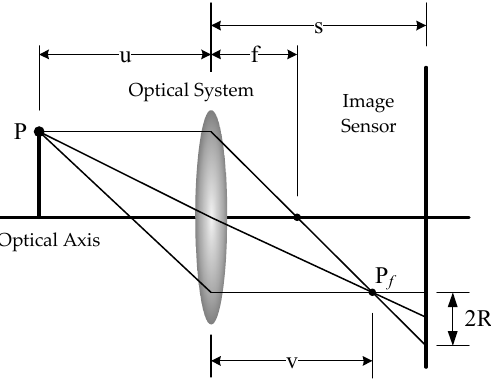
Figure 6. Schematic diagram of ideal optical system imaging principle.